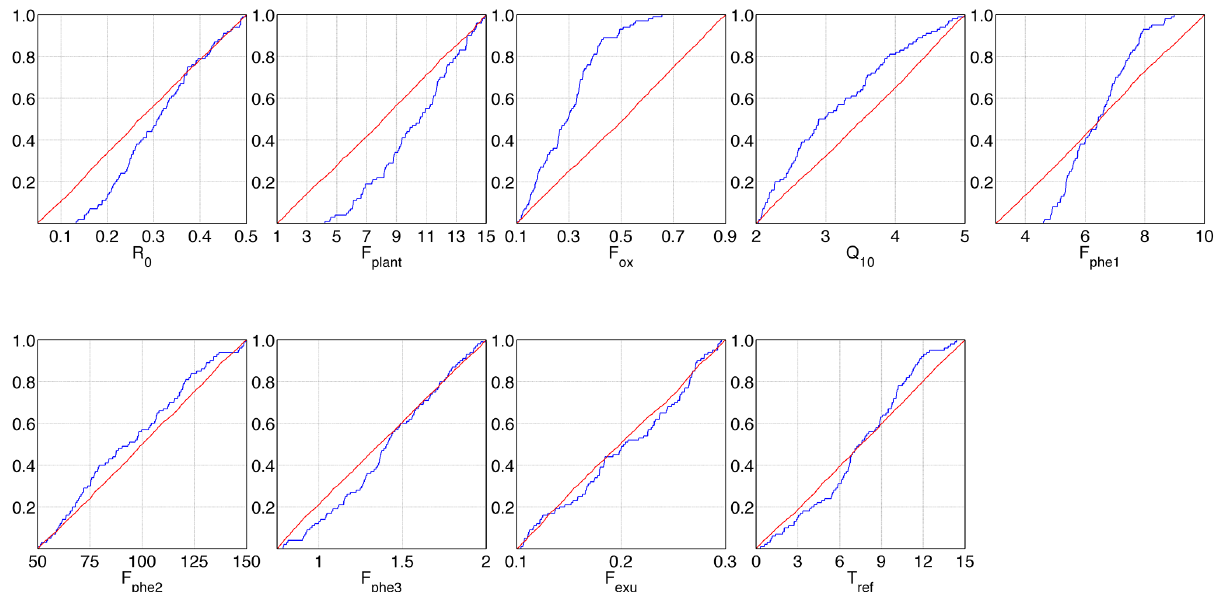
Figure 9. Deviations of cumulative distributions of parameters in CH 4 module (TW1), GPP calculated by method (i). Blue: top 100 model performance. Red: all 3000 model runs. R 0 , CH 4 production rate factor; F plant , CH 4 plant transport rate factor; F ox , CH 4 plant oxidation factor; Q 10 , CH 4 production Q 10 factor; F phe1 , plant phenology factor, base for calculating heat sum; F phe2 , plant phenology factor, heat sum when maximum LAI is reached; F phe3 , plant phenology factor, maximum LAI; F exu , plant root exudate factor; and T ref , reference temperature for